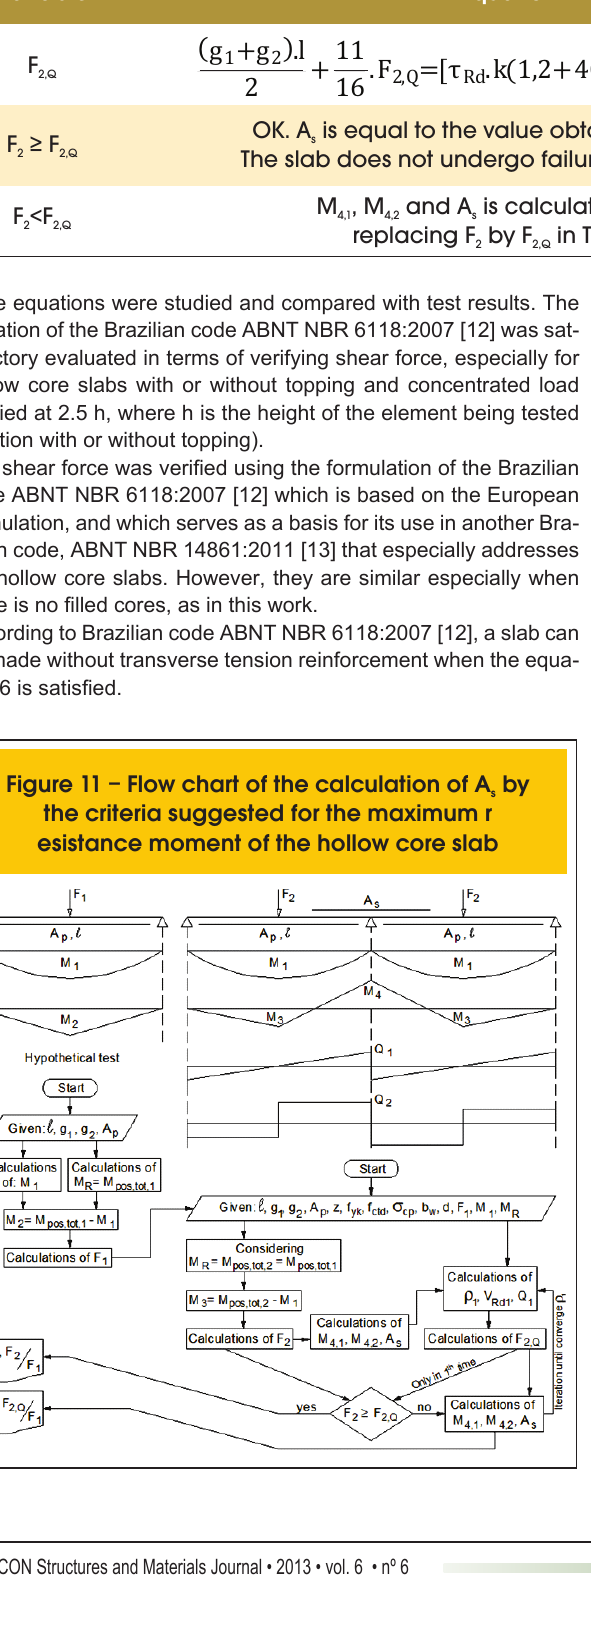
Table 4 – Equations for calculating of hollow core slabs with continuity – verification of shear force Variable